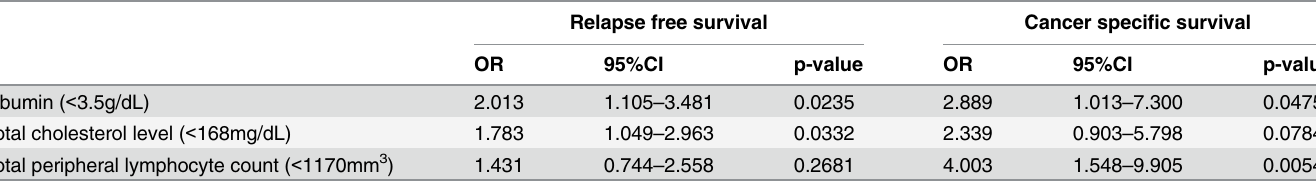
The cut-off values for each of the factors were determined by their respective ROC curves on cancer-specific survival. The cut-off value for the albumin level was 3.5 g/dL, that for the total cholesterol level was 168 mg/dL and that for the total peripheral lymphocyte counts was 1170/ mm 3 . In the univariate analysis for RFS, the albumin level (p = 0.025) and the total cholesterol level (p = 0.032) were found to be predictive factors (Table 6). In the univariate analysis for CSS, the albumin level and the total peripheral lymphocyte level were found to be predictive factors. The multivariate analysis for RFS indicated the CONUT score to be a more useful factor than the total cholesterol level and total peripheral lymphocyte counts (Tables 7, 8 and 9). The Table 6. The results of univariate analysis of the albmin, total cholesterol level and total peripheral lymphocytes count for the survival. Relapse free survival Cancer speci fi c survival OR OR